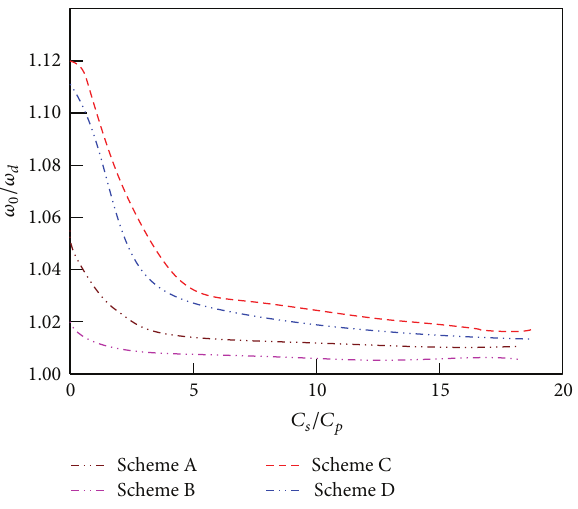
Figure 5: Natural frequency ratio versus capacity